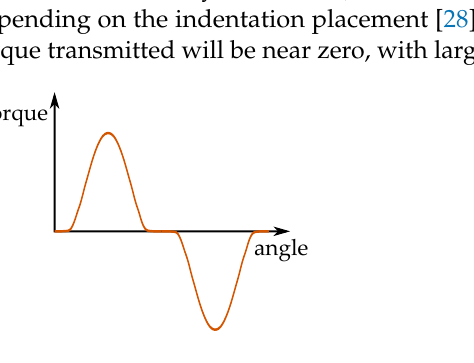
Figure 6. Torque vs. angle characteristics of ball detent type torque